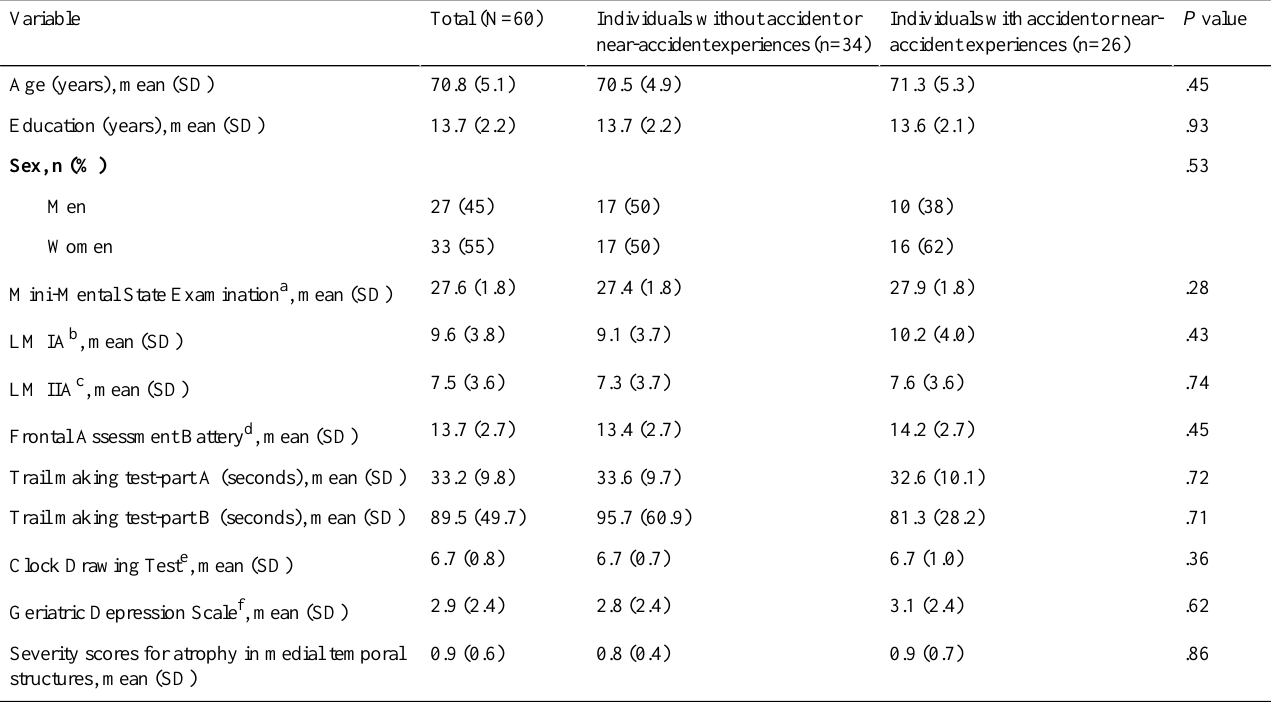
Table 1. Demographic and assessment data for study participants.